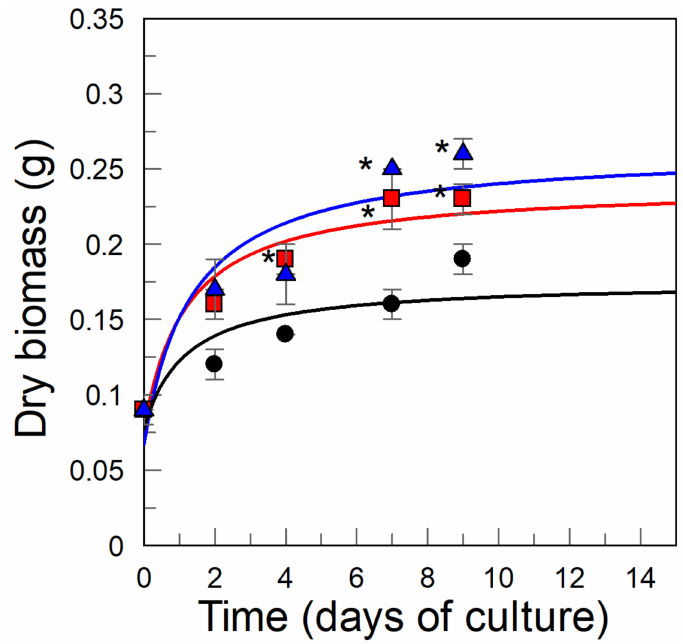
Figure 1. Kinetics of B. × houghtonii suspension cultured cells (BHSCC) growth, expressed as the change of the grams of dry biomass produced over time, in the absence of CDs (control, - • -) and in the presence of 50 mM M– β –CD (- (cid:4) -) and HP– β –CD (- (cid:78) -). Values are given as the mean ± SD of three independent replicates, and (*) refers to significant di ff erences between control and treatments ( p < 0.05). Solid lines are the theoretical curves obtained by fitting the experimental data to a Michaelis—Menten type